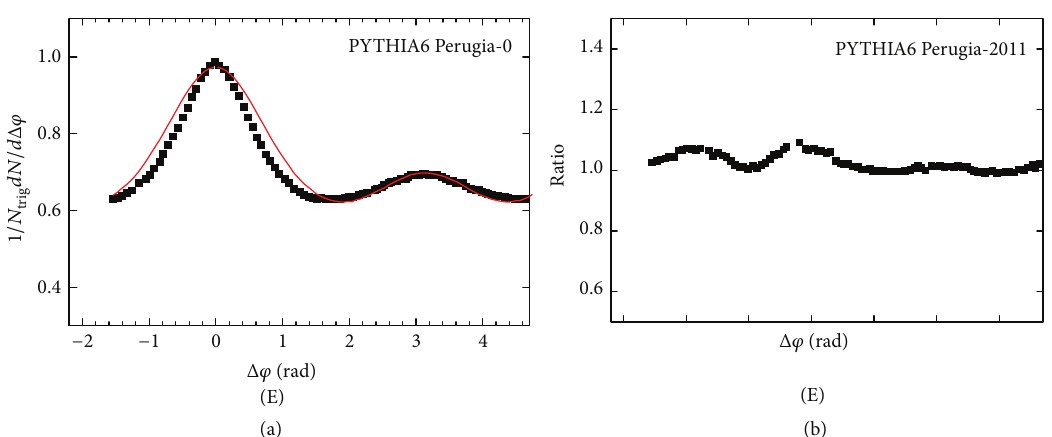
= 7 TeV. (b) The ratio of fit to data. The symbols in (a-A) denote Figure 2: (a) Dihadron azimuthal correlations in p - p collisions at √𝑠 NN the experimental data of the ALICE Collaboration at the LHC [13], and the symbols in (a-B), (a-C), (a-D), and (a-E) correspond to results calculated by the Monte Carlo generators PHOJET, PYTHIA6 Perugia-2011, PYTHIA8 4C, and PYTHIA6 Perugia-0, respectively. The lines are our results calculated by the multisource thermal model.